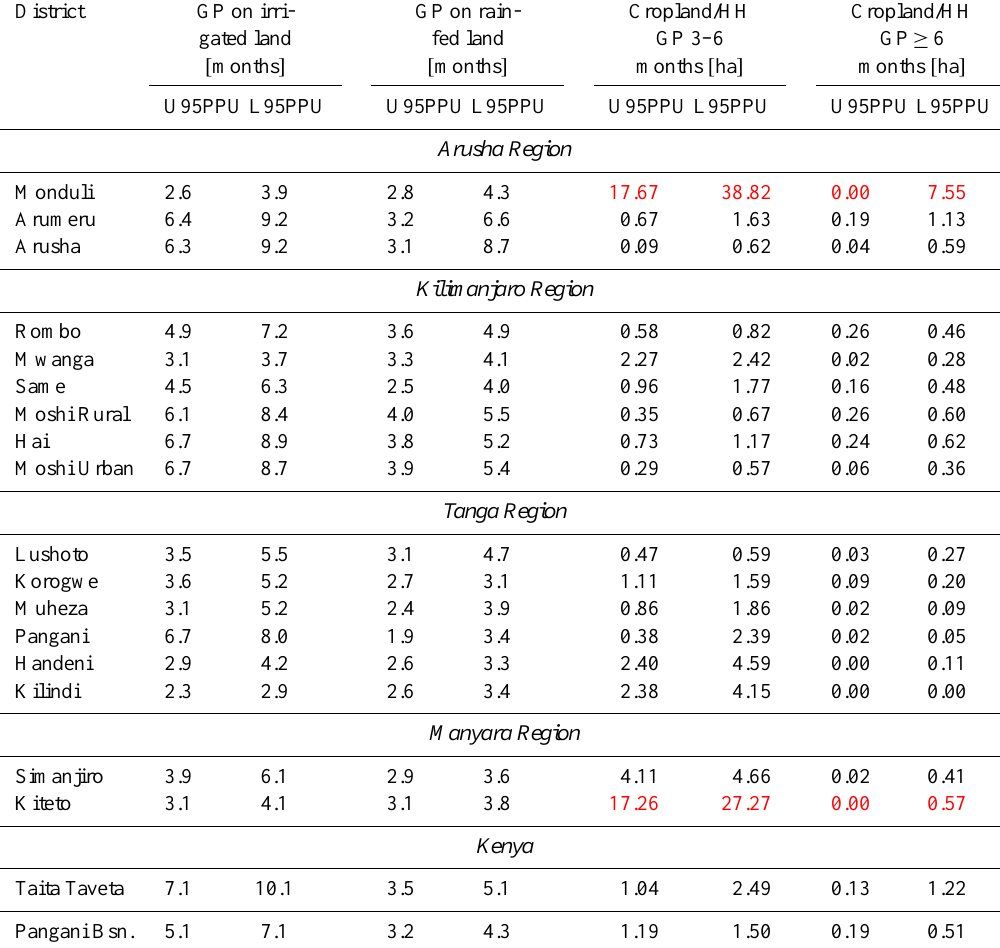
Table 5. Average growing period (GP) duration on irrigated and rainfed land, and available cropland per farming household (HH) on which GP durations of 3–6 months, or ≥ 6 months, respectively, are reached. Cropland per household values are printed in red for Monduli and Kiteto Districts due to unreliable data on the number of farming households.